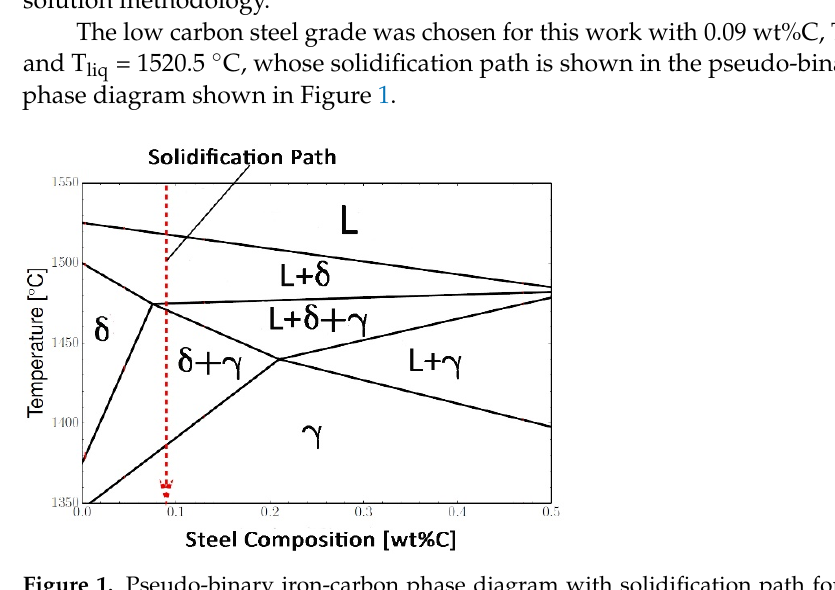
( b ) Figure 2. Temperature dependent material properties for 0.09 wt%C steel grade: ( a ) elastic modu- lus and enthalpy and ( b ) thermal conductivity and thermal expansion. The phase fraction and temperature-dependent material properties in Figures 1 and 2 and other interfacial calculations are an integral part of UMAT and other user-defined subroutines, which are programmed and linked with Abaqus to provide a complete mul- tiphysics model of steel solidification on the continuum level [3,8]. Generalized plane strain conditions can realistically recover a full 3D stress state in long objects under thermal loading [3,4], such as in continuous caster in Figure 3a with the considerable length and width. The slice domain in Figure 3b travels down the mold with casting velocity in a Lagrangian frame of reference. It consists of a single row of 300 coupled thermo-mechanical generalized plane strain elements with 602 nodes, which pro- vide generalized plane strain condition in axial (z-direction). In addition, a second gener- alized plane strain condition was imposed in the y direction by coupling the vertical dis- placements of all nodes along the bottom edge of the domain. Time-dependent profiles of thermal fluxes leaving the chilled surface on the left side of the domain and their displace- ment due to mold taper and other interactions with the mold provide the solidifying slice domain’s thermal and mechanical boundary conditions. These profiles’ temporal varia- tions are inputs for the sequence deep learning methods, while the calculated temperature and stress histories are their targets (labels).